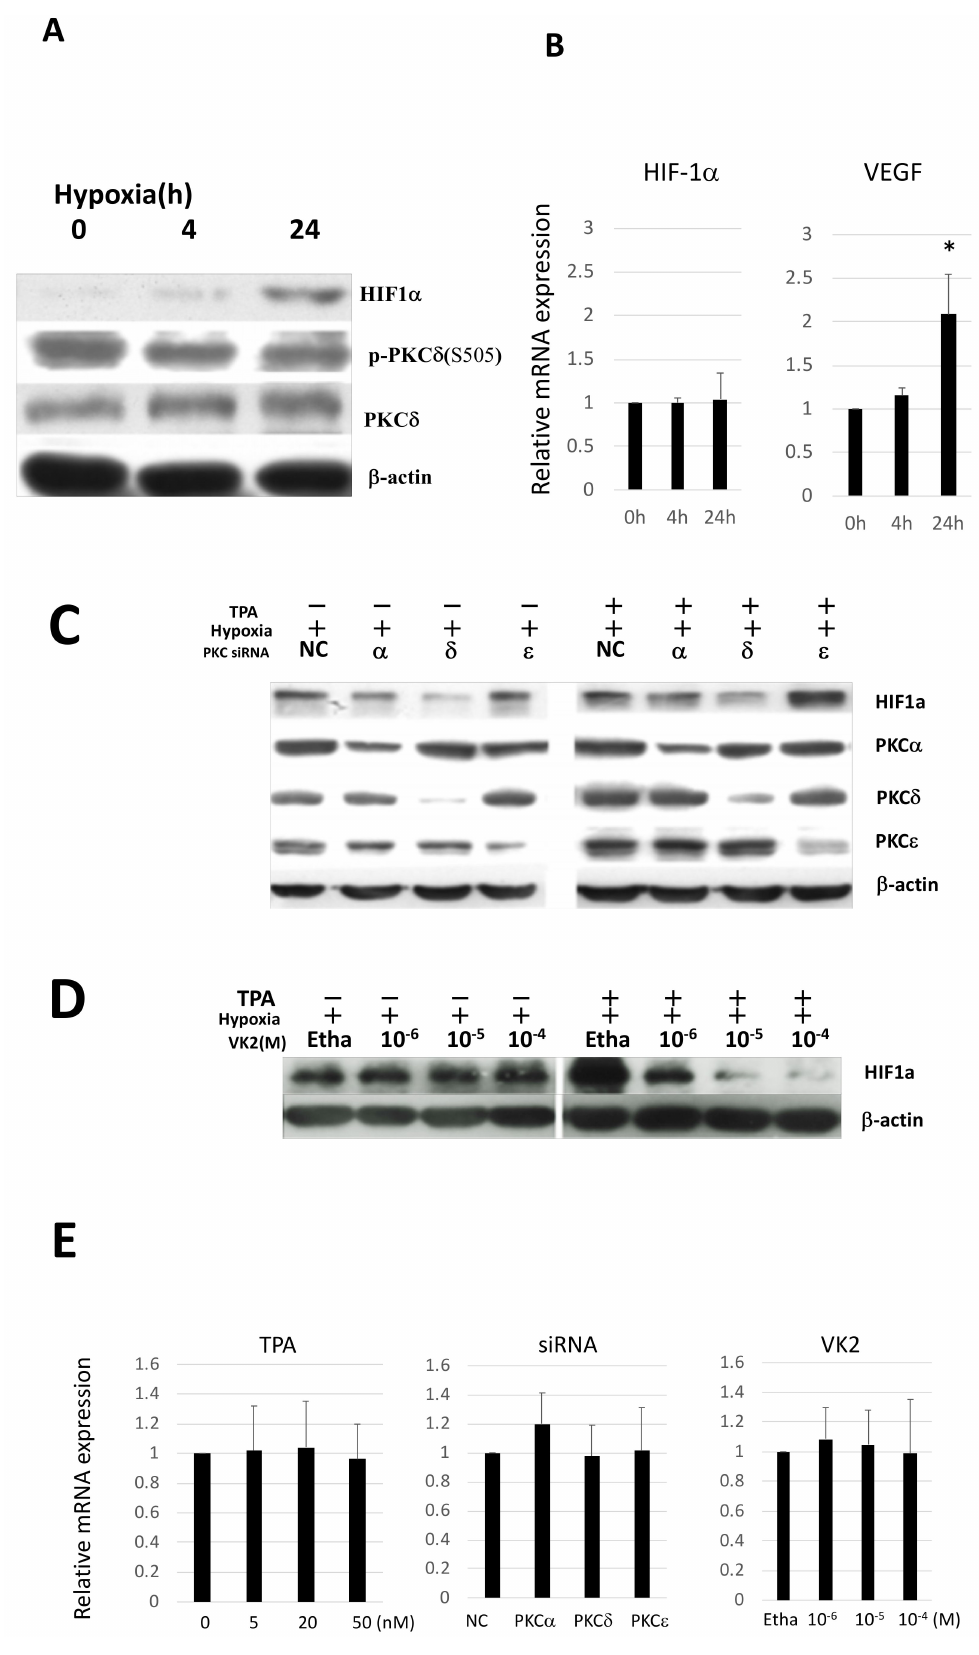
Figure 2. The effects of hypoxia, TPA, PKC isoforms and VK2 on the expression of HIF-1 α mRNA and protein were examined in Huh7 cells. ( A ) The expression of HIF-1 α protein was induced under hypoxic